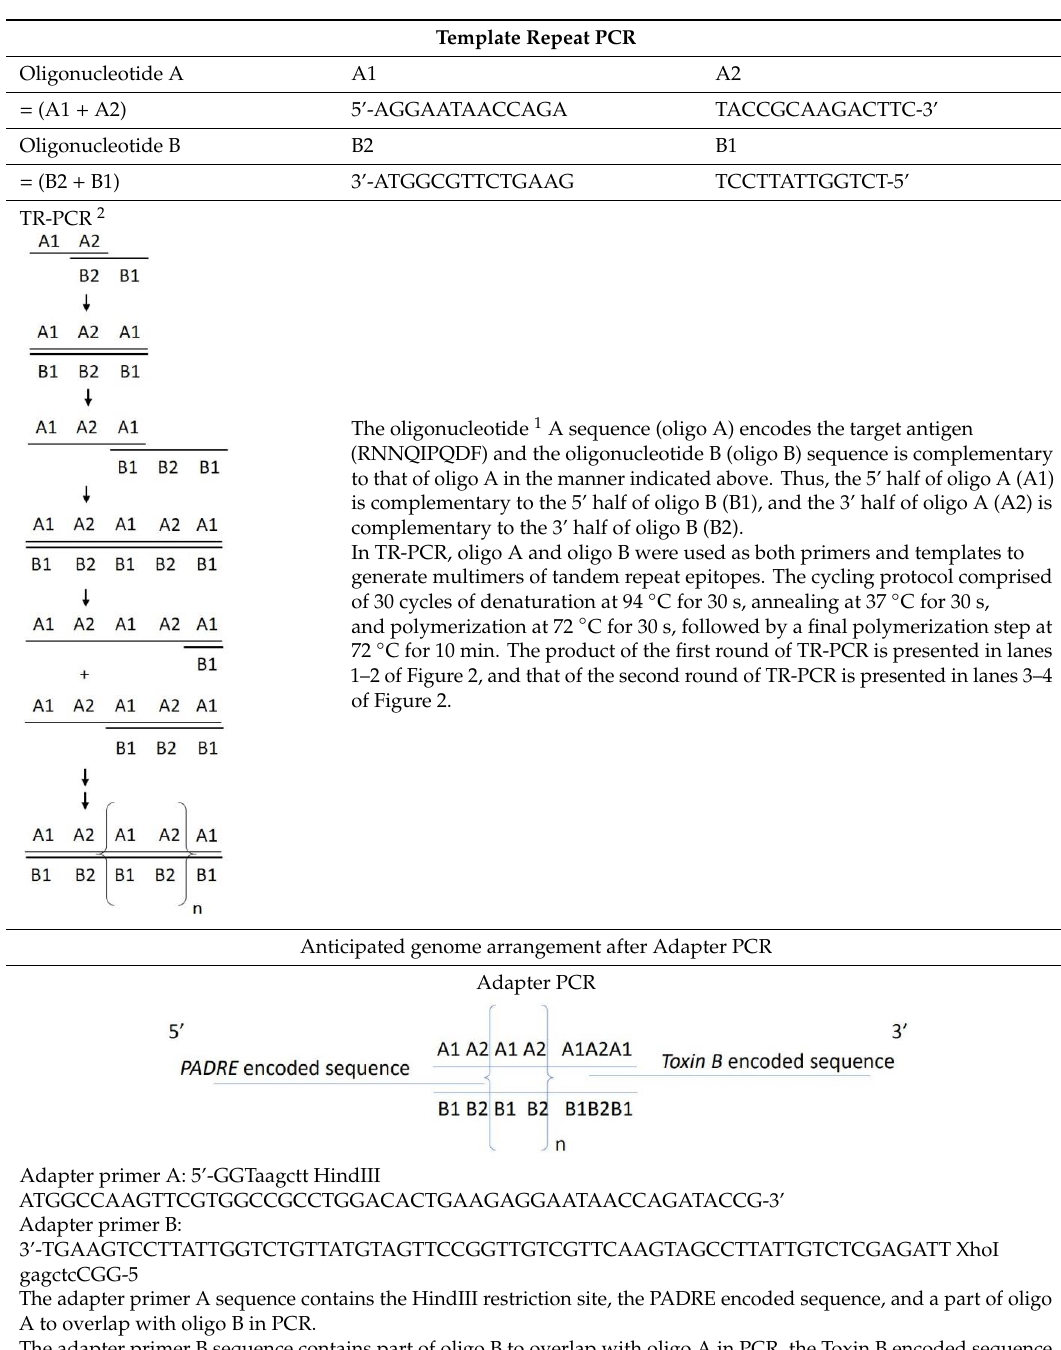
Table 2. Strategies used in template repeat PCR and adapter PCR to construct a suite of linearly arranged PADRE-(RNNQIPQDF)n-Toxin B expression cassettes for cloning into the glutathione S transferase (GST) vector.